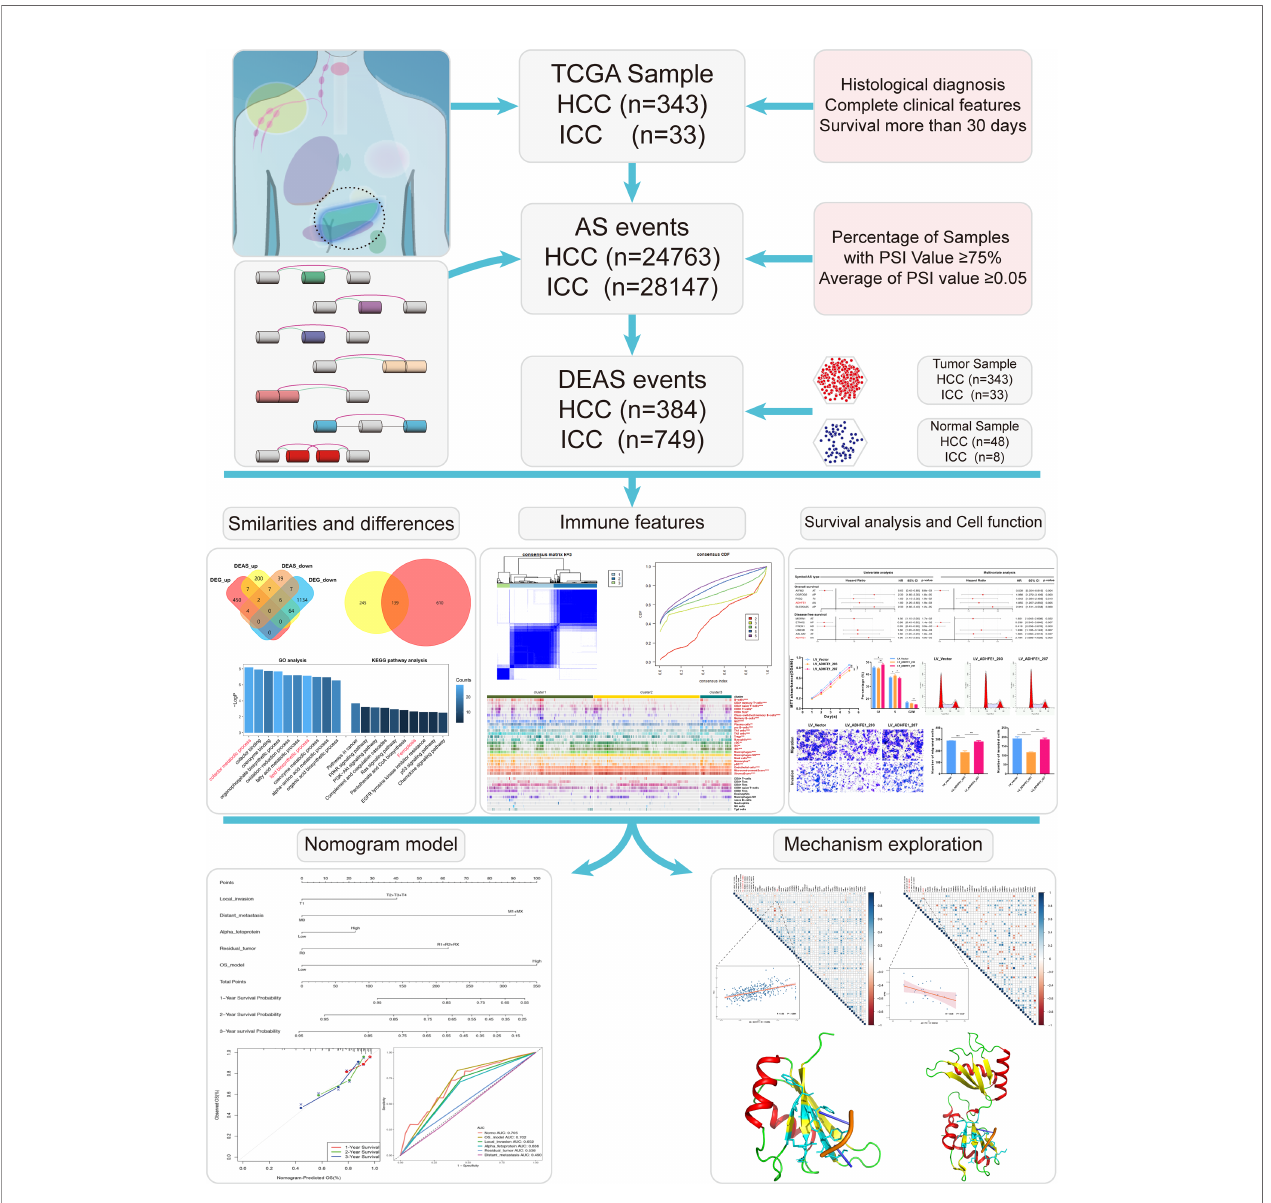
FIGURE 2 | The fl owchart of the present